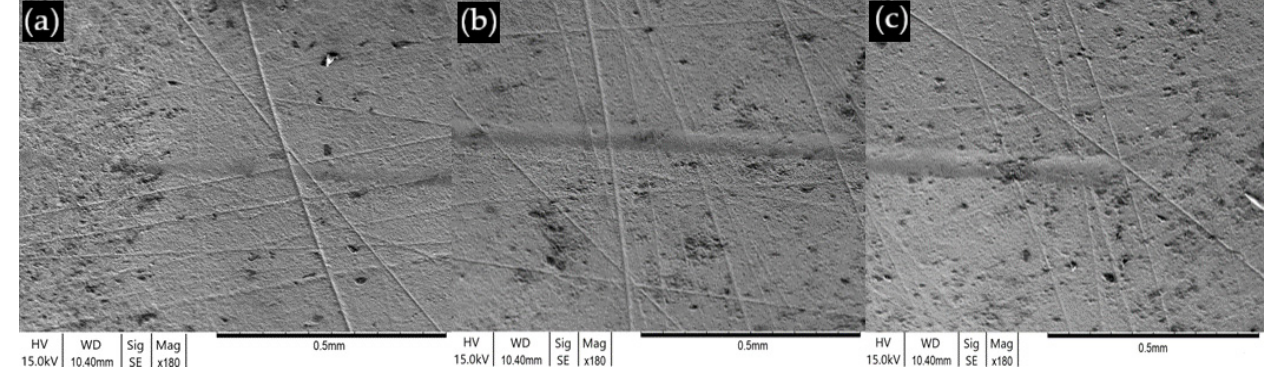
Figure 21. ( a ) Coating B scratch position 1, ( b ) Coating B scratch position 2 and ( c ) Coating B scratch position 3 at ×180 magnification.